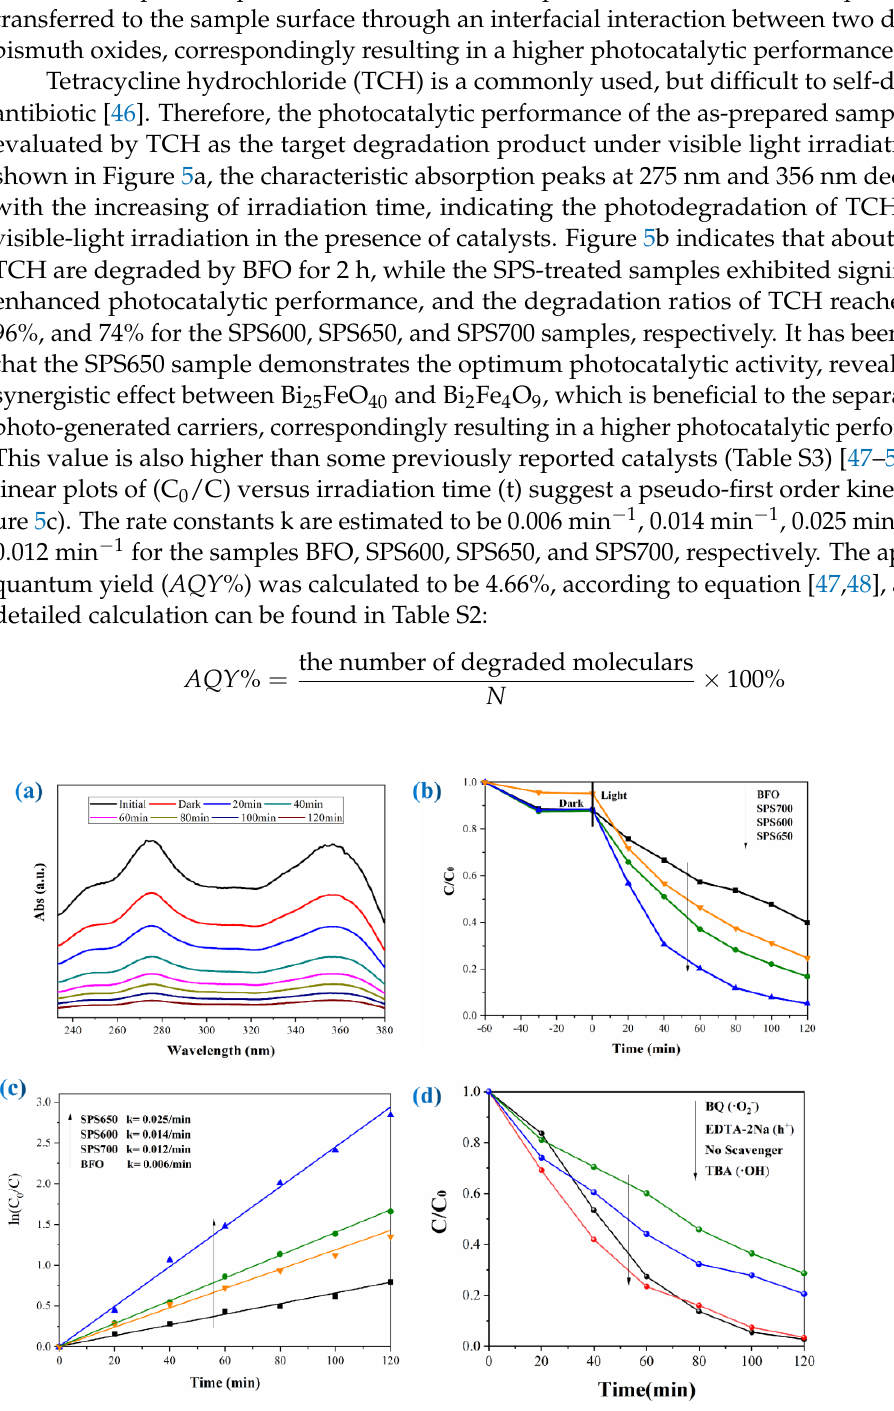
Figure 5. ( a ) Absorption spectra of the TCH solution over SPS650 under visible light irradiation; ( b ) photocatalytic degradation of TCH under visible light irradiation for as-prepared samples; ( c )